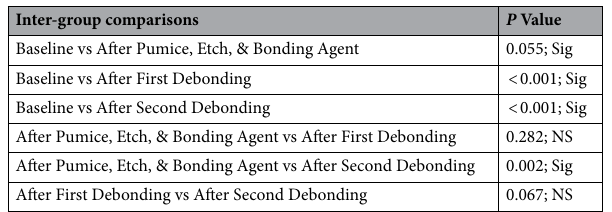
Table 2. Intergroup comparison for enamel. Sig: Significant; NS: Not